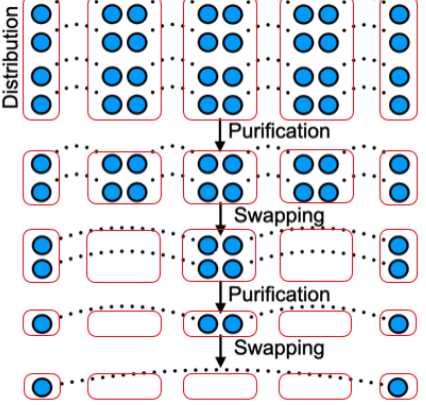
Figure 1. Operations of a QR network with hierarchical BSMs: in the initial entanglement distribution, multiple Bell states are established across each pair of adjacent repeater nodes; then, purification and swapping iterations are executed, until the end-to-end entangled state has been